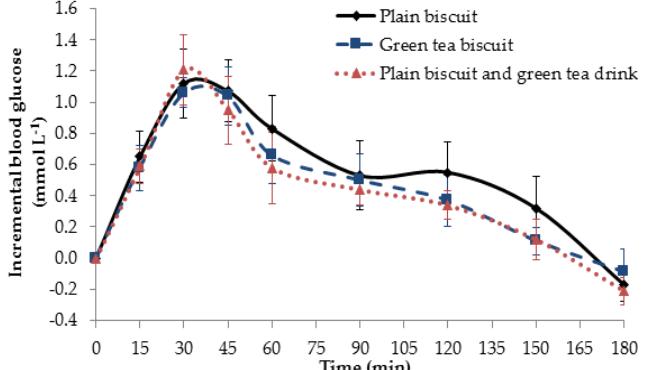
Figure 5. Mean incremental blood glucose response curves after ingestion of control and test meals over 180 min. ( - ◆ - ) represents the blood glucose curve of the control meal that consisted of plain biscuit consumed with warm water, ( - ■ - ) represents the blood glucose curve of the test meal with Matcha green tea biscuits consumed with warm water, and ( .. ▲ .. ) represents the blood glucose curve of the test meal with plain biscuits consumed with a Matcha green tea drink. Data expressed as the amount of blood glucose in mmol·L −1 and the error bars represent the SEM ( n = 10).